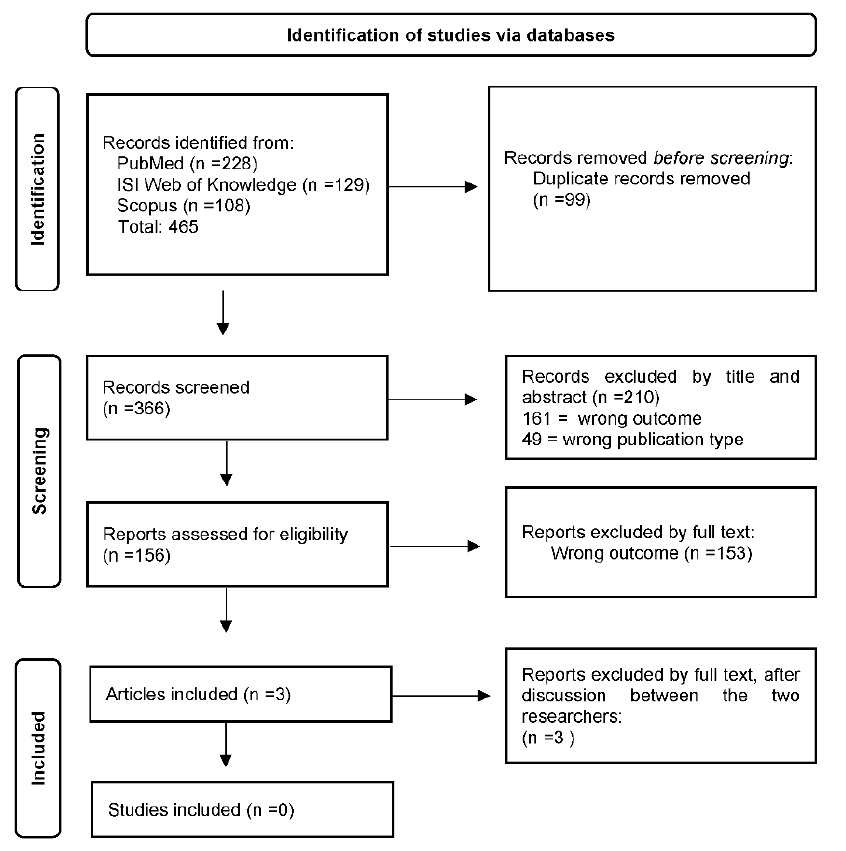
Figure 1. PRISMA flowchart. Symbols: n = number.